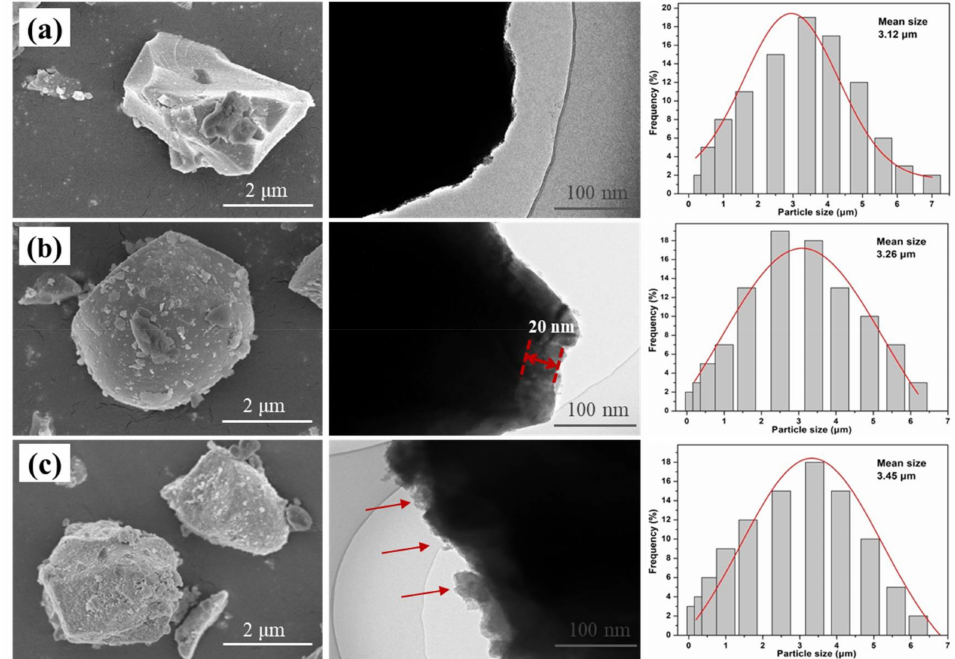
Figure 1. Scanning electron microscopy (SEM) micrographs, transmission electron microscopy (TEM) images and the distribution of average particle size of SAOED particles before and after modification: ( a ) uncoated SAOED phosphor; ( b ) SiO 2 coated SAOED (SiO 2 @SAOED); ( c ) (3-aminopropyl) trimethoxy-silane (APTMS) coated SiO 2 @SAOED phosphors (NH 2 @SiO 2